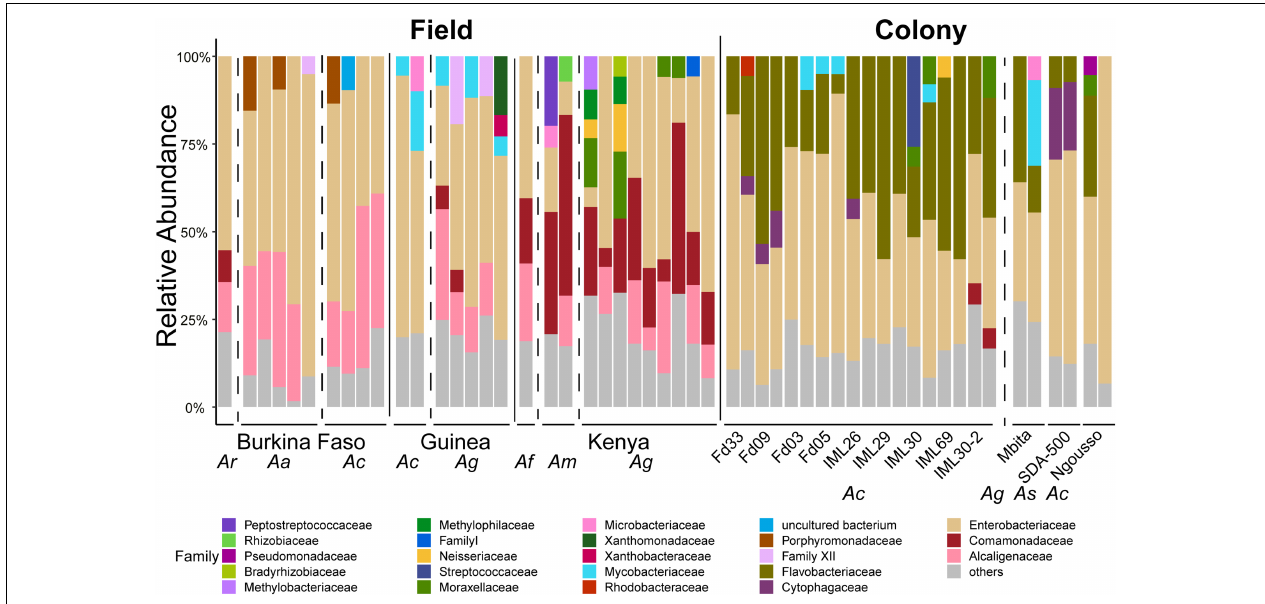
FIGURE 7 | Taxonomic profiles of the prokaryotic microbiome in larvae sampled from the field and from laboratory colonies. OTUs are shown at the Family level. All OTUs present at less than 5% frequency are grouped together and classified as others. Each bar represents the prokaryotic taxonomic composition of one pool of larval samples from a given country or laboratory colony. All larval sample DNA pools contain only samples from a single mosquito species. Dashed vertical lines separate samples of different mosquito species ( Ar , Anopheles rufipes ; Ac , Anopheles coluzzii ; Ag , Anopheles gambiae; Af, Anopheles funestus; Am, Anopheles maculatus; As, Anopheles stephensi ) and solid lines separate samples from different countries and samples from the field from those from laboratory